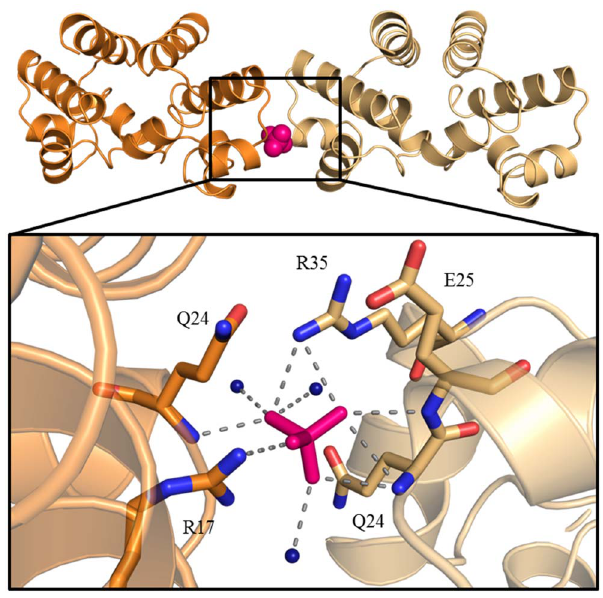
Figure 4. Conformation of the flexible loop of C.Esp1396I. (A): The three observed loop conformations observed in crystal structures of the native protein. The two alternative C.Esp1396I loop positions in 3G5G are shown in light blue (conformation I) and light green (conformation II) and the high resolution wild type loop position from 4I6R is shown in orange (III). (B): The side chains of residues S45, R46 and N47 are displayed as sticks.